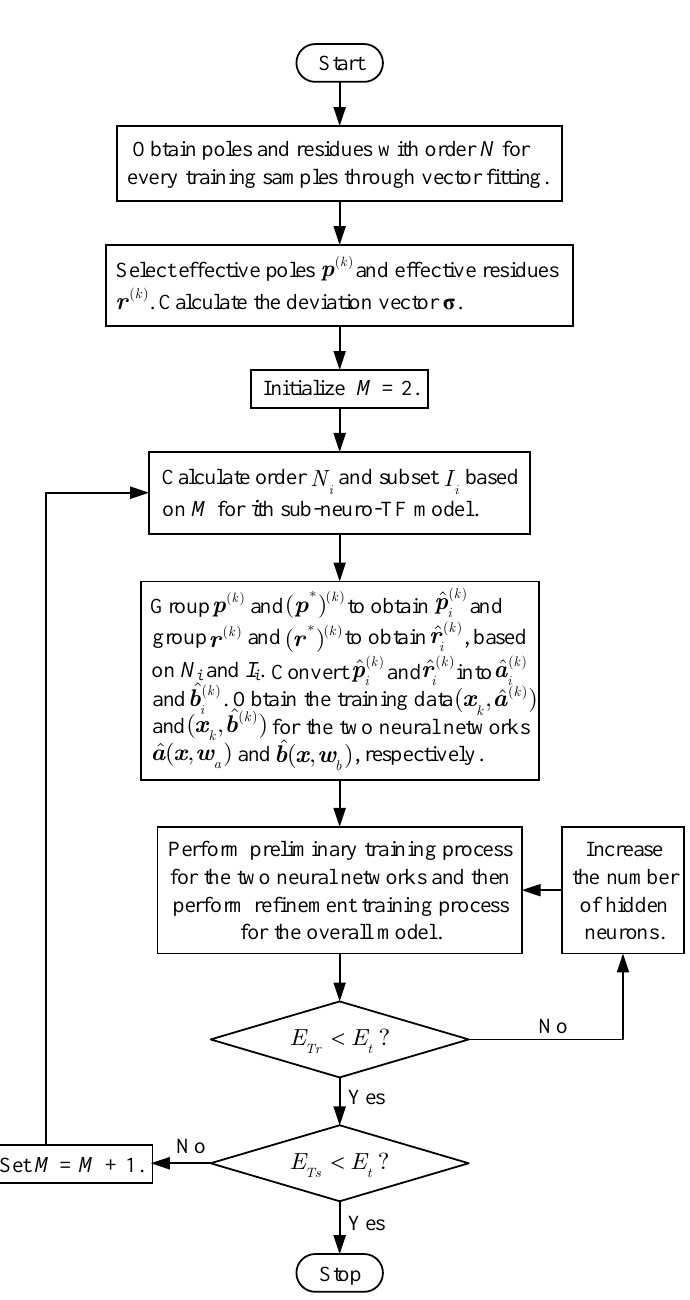
Figure 2. The flow diagram of the overall model development process using the proposed decomposition